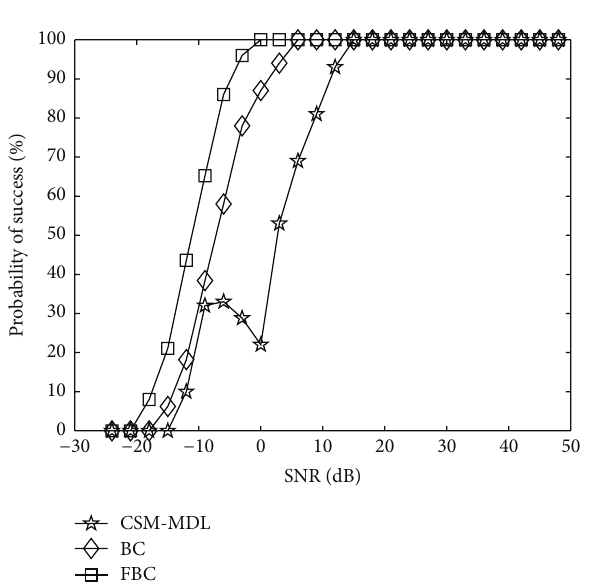
Figure 5: Probability of success versus number of snapshots for uncorrelated signals in non-Gaussian white